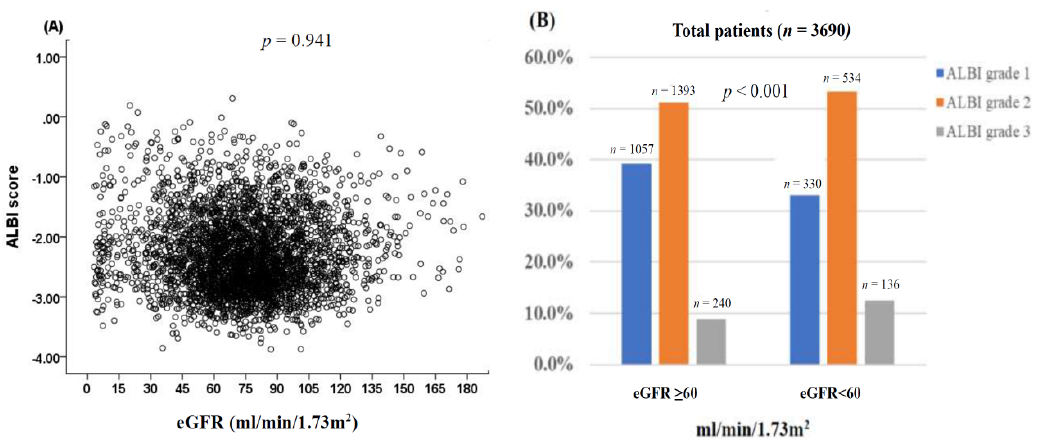
Figure 1. ( A ) The correlation of estimated glomerular filtration rate (eGFR) and albumin-bilirubin (ALBI) score. There was no significant correlation between eGFR and ALBI score ( p = 0.941). ( B ) Distribution of ALBI grade was stratified by the eGFR at a cuto ff of 60 mL / min / 1.73 m 2 . The distribution of patients based on ALBI grade was 1057 patients (ALBI grade 1), 1393 patients (ALBI grade 2), and 240 patients (ALBI grade 3) in eGFR ≥ 60 mL / min / 1.73 m 2 and 330 patients (ALBI grade 1), 534 patients (ALBI grade), and 136 patients (ALBI grade 3) in GFR < 60 mL / min / 1.73 m 2 . Patients with ALBI grade 2 or 3 were more often associated with lower eGFR ( p < 0.001).